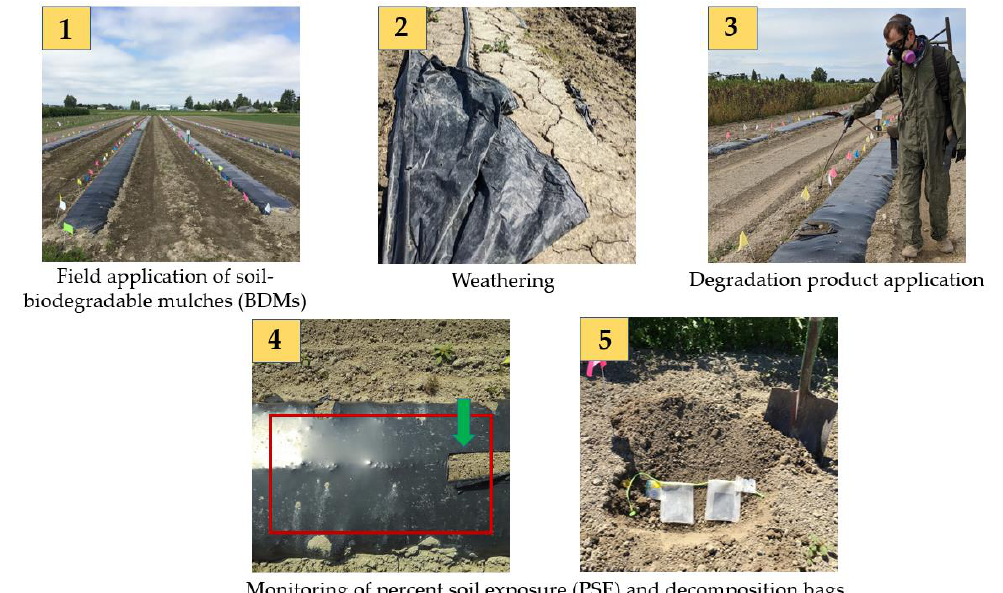
Figure 1. Methodology followed in the 2019/2020 and 2020/2021 field trials.